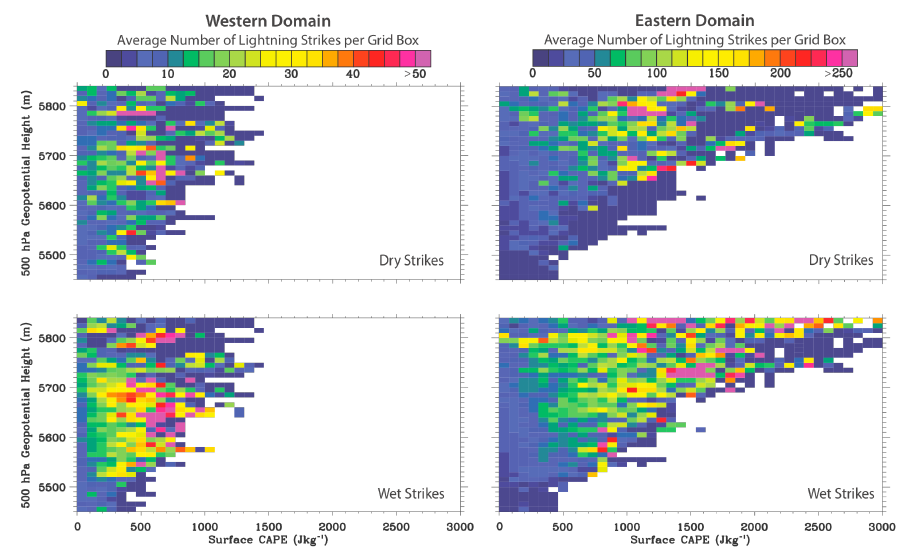
Figure 7. Fig. 7. The average number of lightning strikes (dry and wet) per grid box as a function of CAPE and 500hPa geopotential heights for the western domain (left) and the eastern domain (right). White areas do not contain observed data and the values of the western domain color bar are 1/5 of the values in the eastern domain color bar.